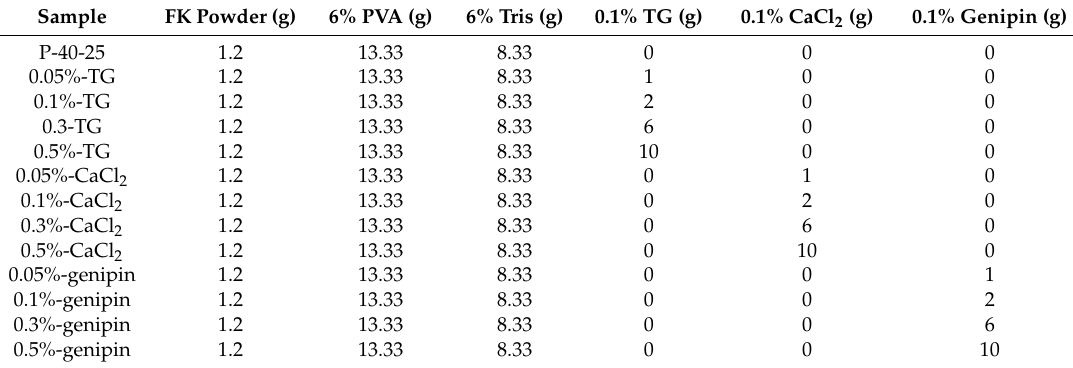
Table 1. Addition amount of each component in the blend films. FK: feather keratin, PVA: